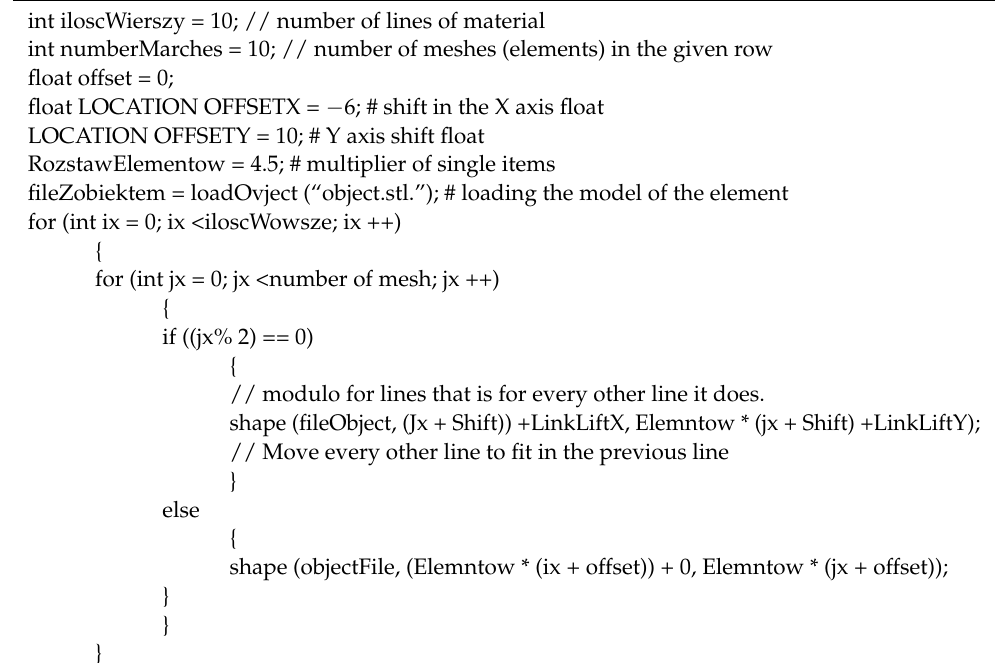
Algorithm 1: Algorithm that creates and sets the material of the chainmail